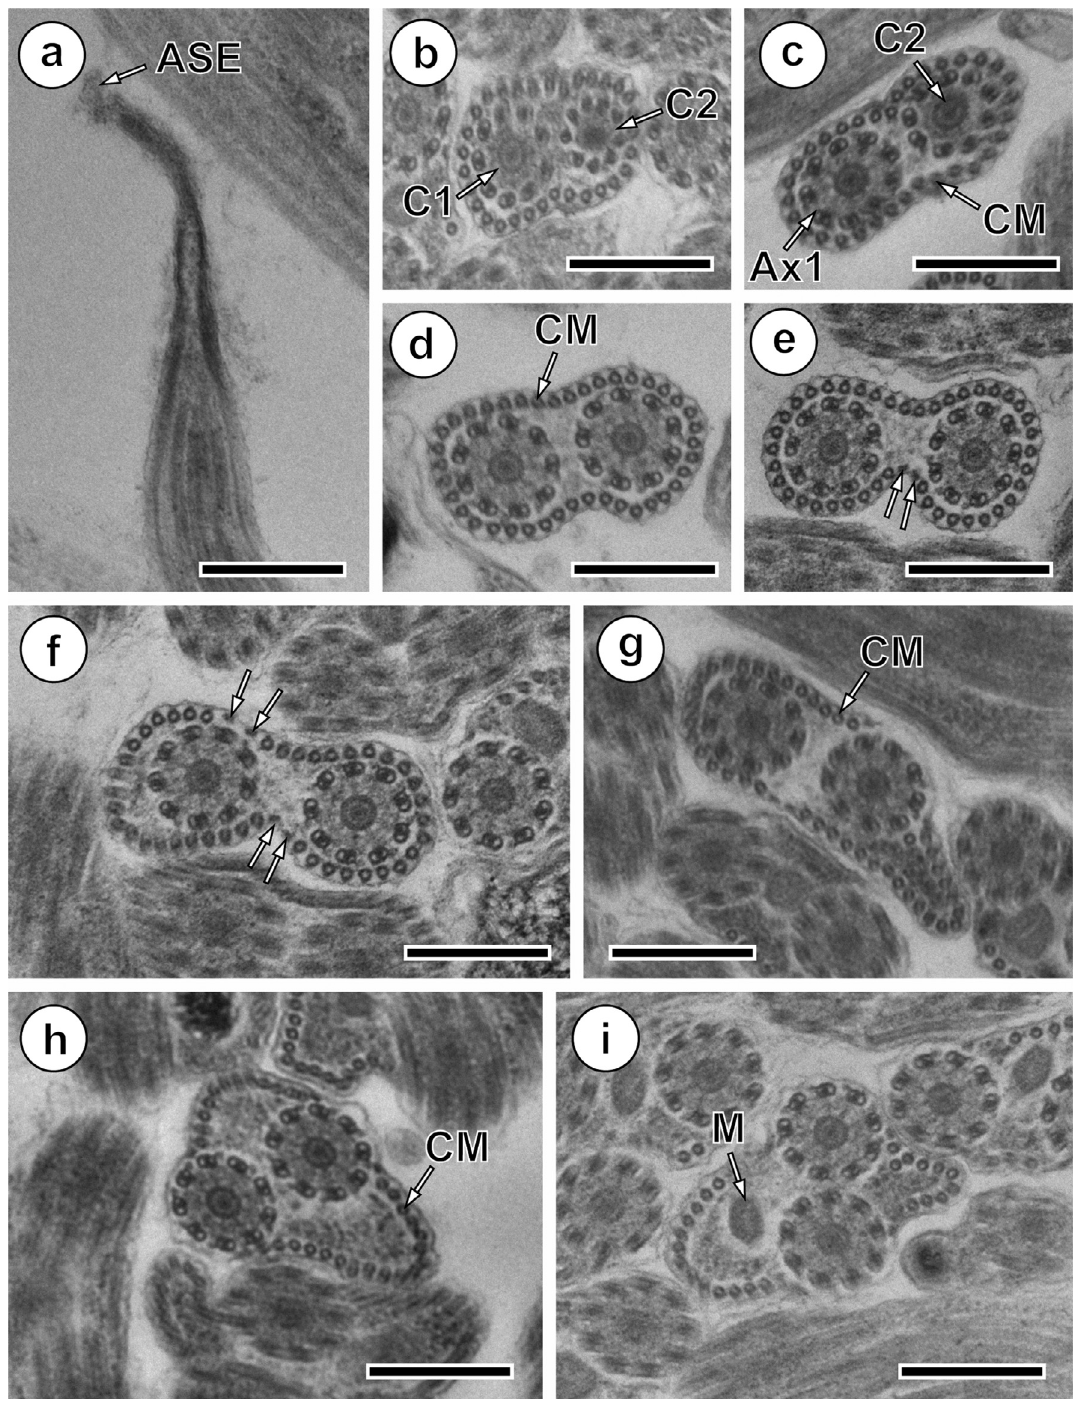
Figure 1. Mature spermatozoon of Collyricloides massanae . (a) Sharp morphology of the anterior spermatozoon extremity (ASE). (b, c) Cross-sections in Region I showing two centrioles (C1 and C2) corresponding to both axonemes and continuous layer of submembranous cortical microtubules (CM). Ax1, first axoneme. (d) Cross-section in which both axonemes are already formed and surrounded by a continuous layer of parallel cortical microtubules. (e, f) Consecutive cross-sections in the middle part of Region I exhibiting two and four attachment zones (arrows), interrupting the continuous layer of cortical microtubules. (g–i) Posterior part of Region I showing in cross- sections both axonemes and cortical microtubules organised into two fields separated by the four attachment zones. The appearance of the mitochondrion is also noticeable (M). Scale in l m: (a), 0.5; (b–i),